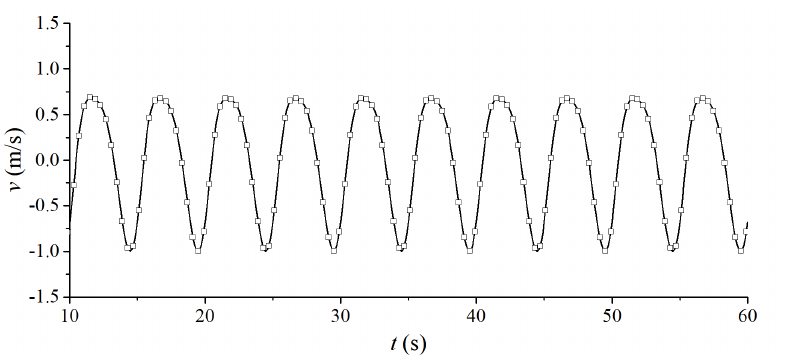
Figure 12. Velocity time histories of the floater when linear damping coefficient C is 3000 N/(m/s).